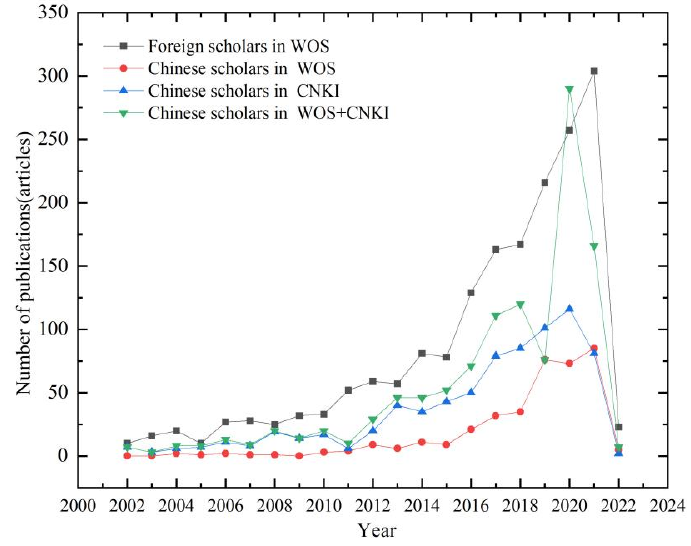
Figure 1. Publication